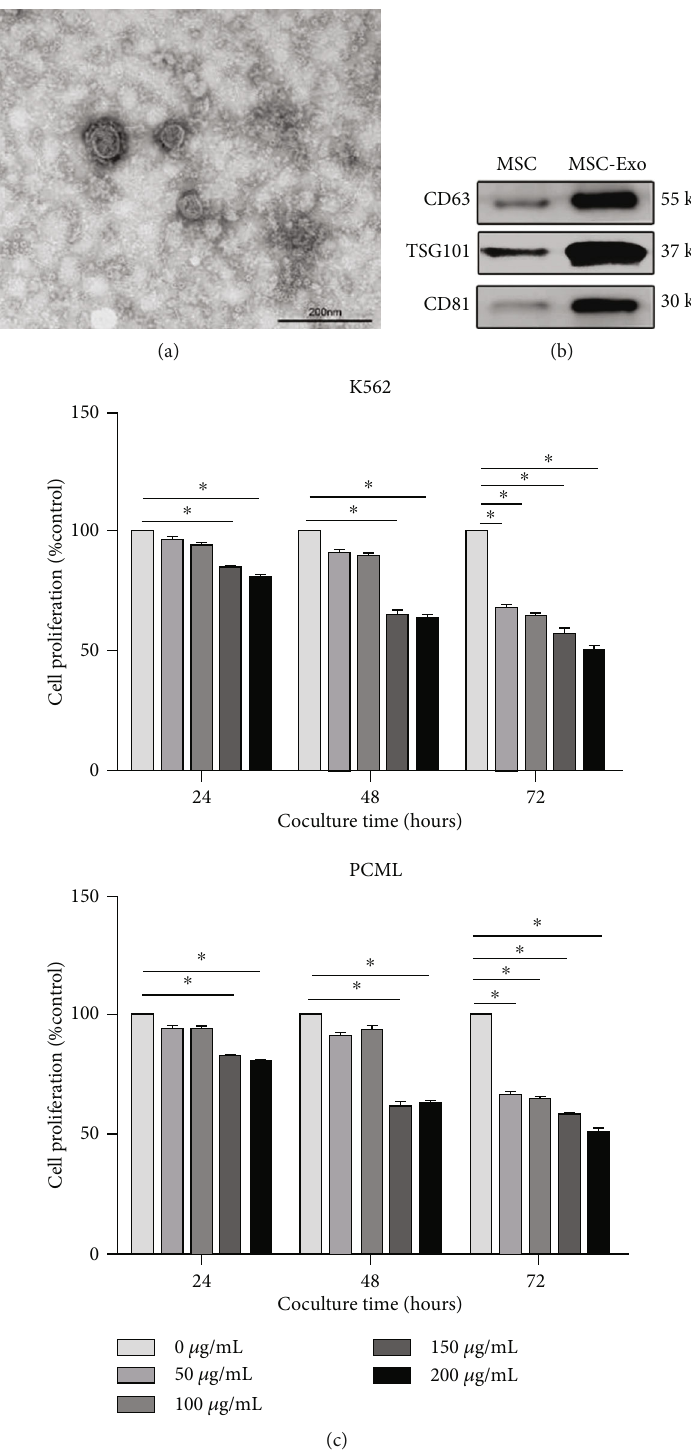
Figure 1: Bone marrow MSC-Exo inhibit CML cell proliferation in vitro. (a) Transmission electron microphotographs of exosomes isolated from bone marrow MSC. The scale bars indicate 100 nm. (b) Detection of CD63, TSG101, and CD81 expression in MSC-Exo by western blotting. (c) Cell proliferation of K562 and PCML cells cocultured with di ff erent concentrations of hBMMSC-Exo (0, 50, 100, 150, and 200 μ g/mL). The data were expressed as the mean ± SD of the three independent experiments. ∗ p < 0 : 05 Student ’ s t